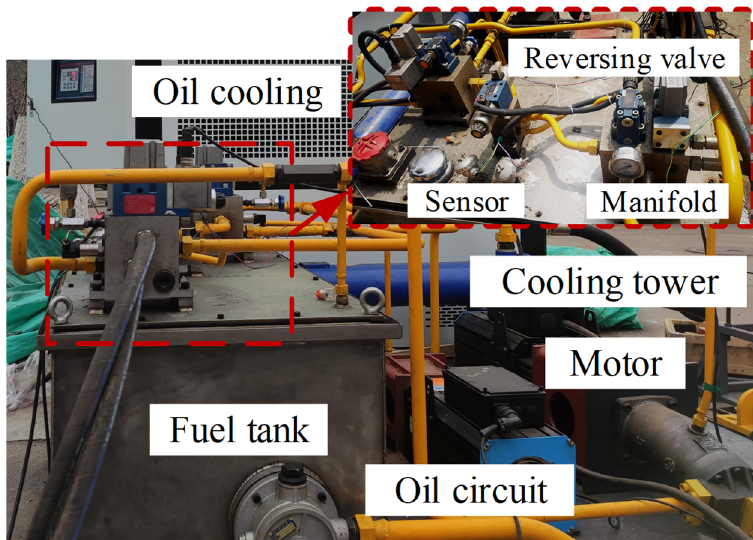
Figure 8. Testing machine hydraulic system.